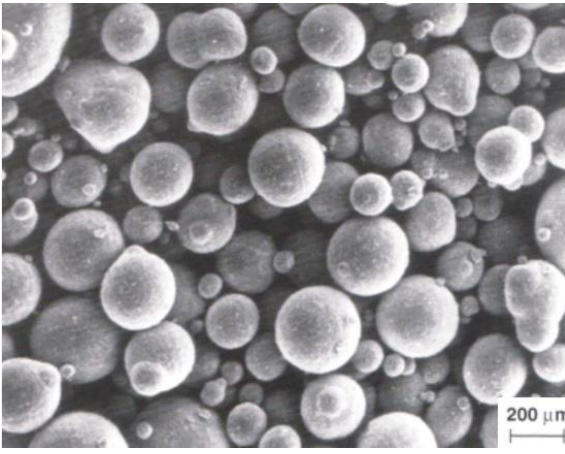
Figure 4. Granules of powder mixture